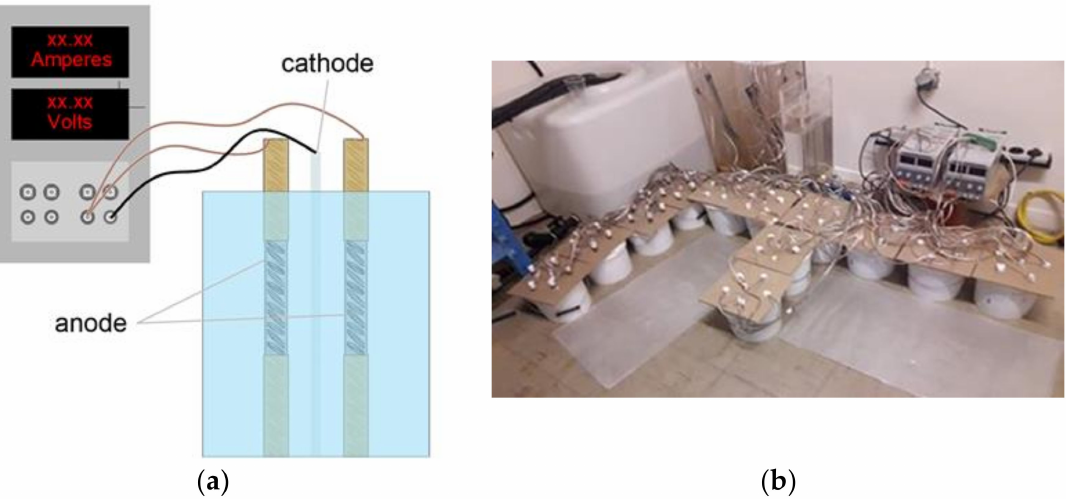
Figure 4. Procedure of accelerated electro-corrosion: ( a ) schematic representation and ( b ) experimental